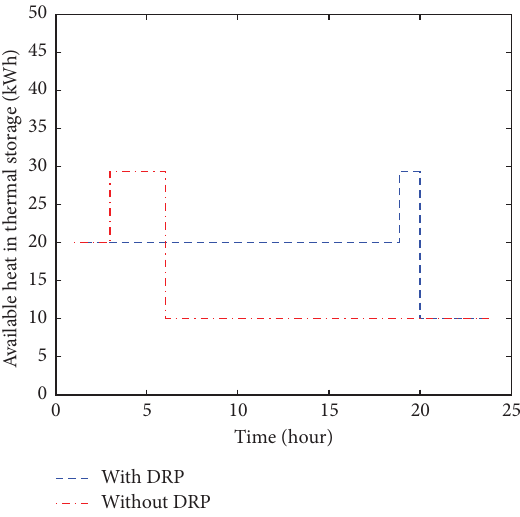
Figure 20: Te heat stored in thermal